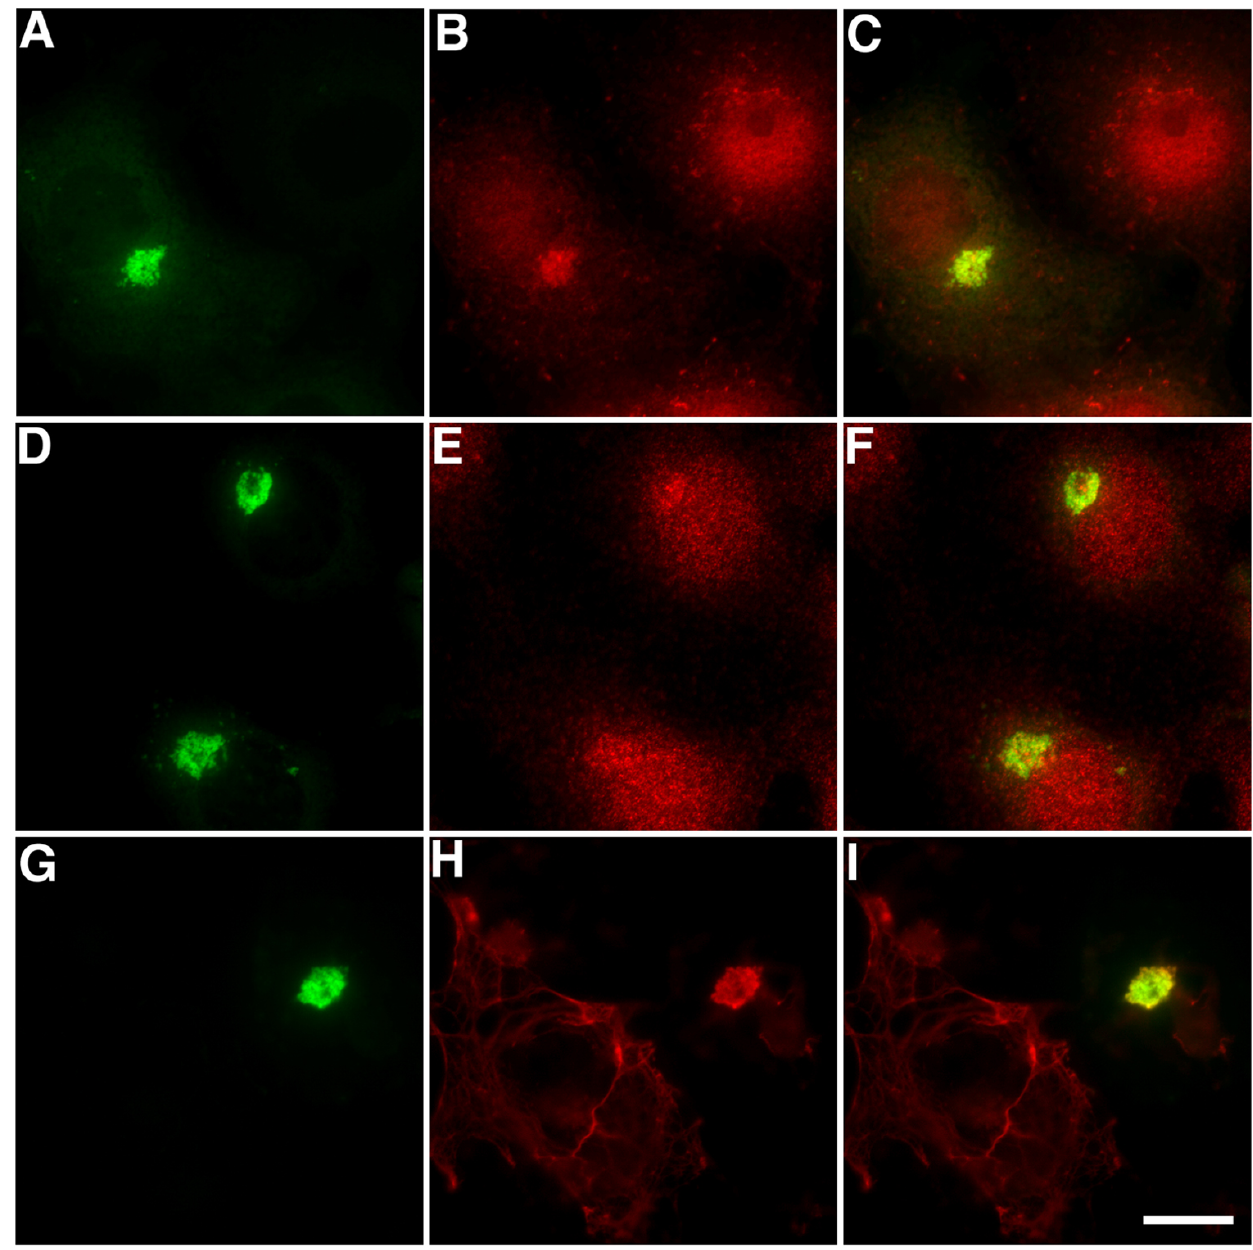
EB1- ∆ N2-GFP aggregates are aggresomes Figure 5 EB1- ∆ N2-GFP aggregates are aggresomes. Cells expressing EB1- ∆ N2-GFP were fixed and co-immunostained for GFP (green, panels A, D and G) and either the 20s proteosomal subunit (red, panel B), ubiquitin (red, panel E) or vimentin (red, panel H). Merged images are shown in panels C, F and I. All three aggresome markers were present in EB1- ∆ N2-GFP aggregates. Bar = 10 µ